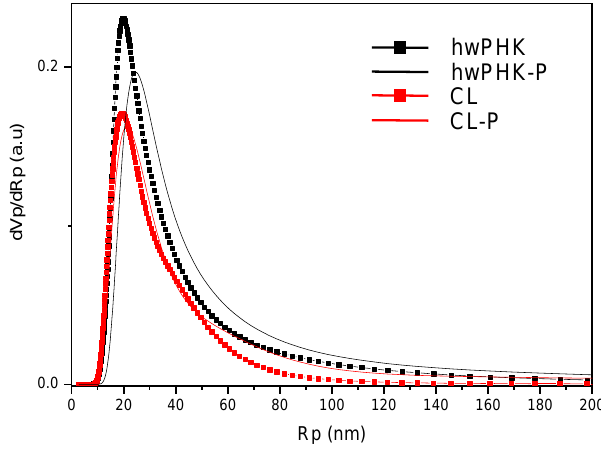
Figure 4. Normalized pore-size distributions as obtained by thermoporosimetry.